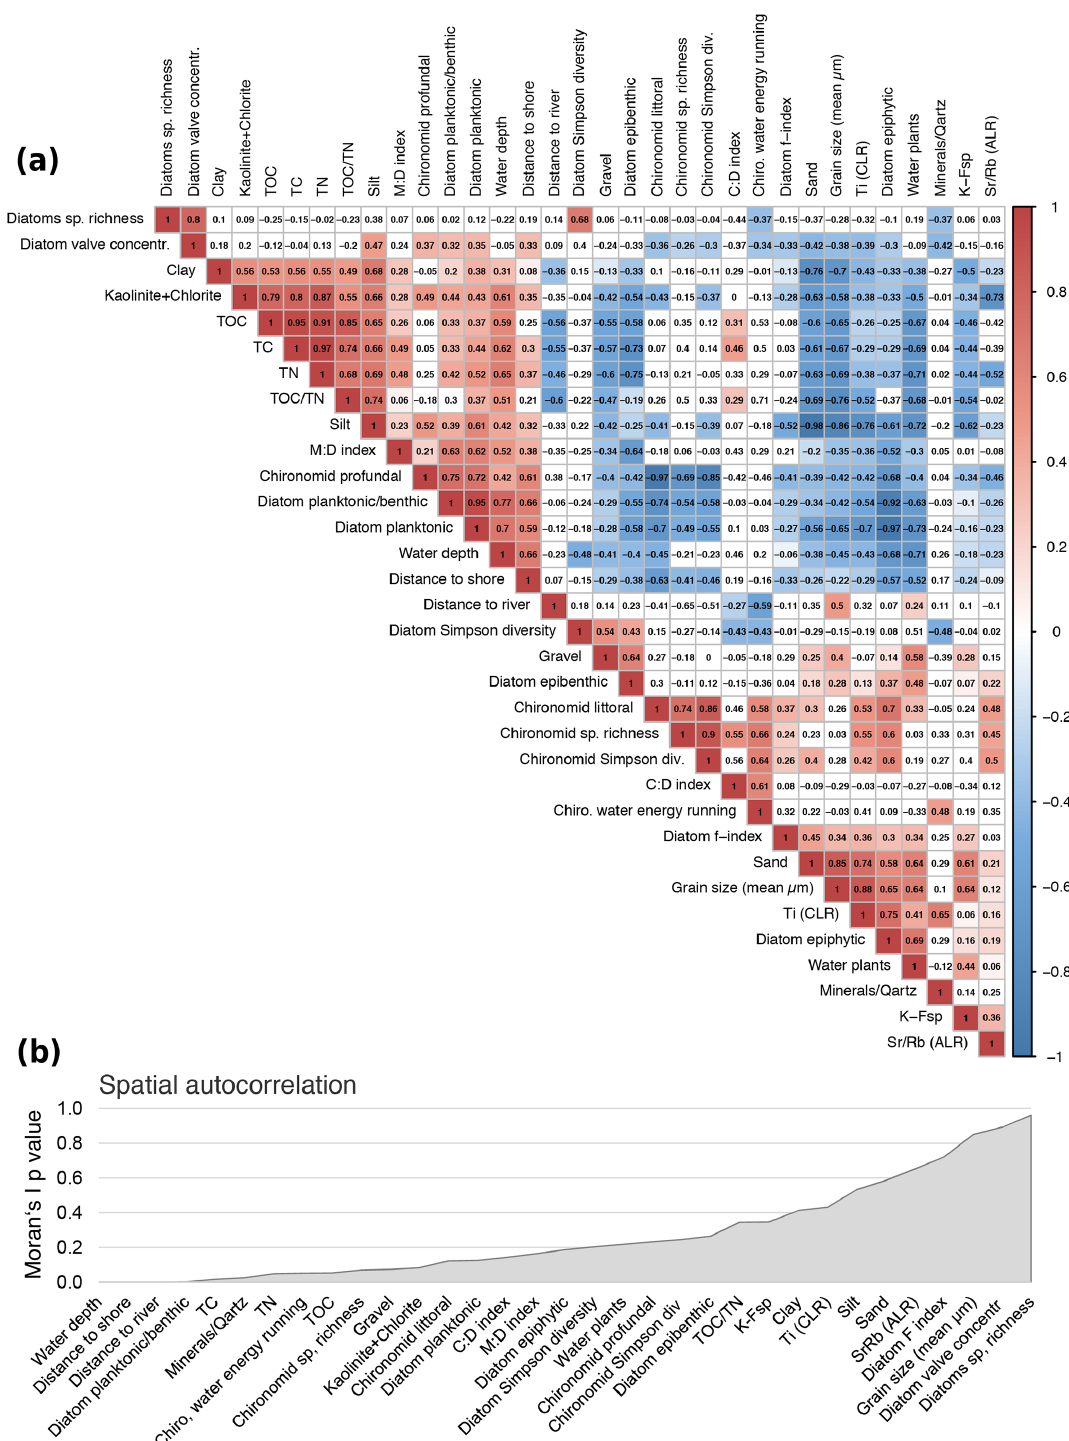
Figure 5. Correlation matrix of selected environmental parameters. (a) Pearson correlation. Positive correlations indicated in red, negative correlations in blue. To keep the false discovery rate below 5%, only p values of < 0 . 001 were used to assign colours (Colquhoun, 2014). (b) Spatial autocorrelation associated with coordinates of sample sites and shown as p values generated by Moran’s autocorrelation coefficient (R package